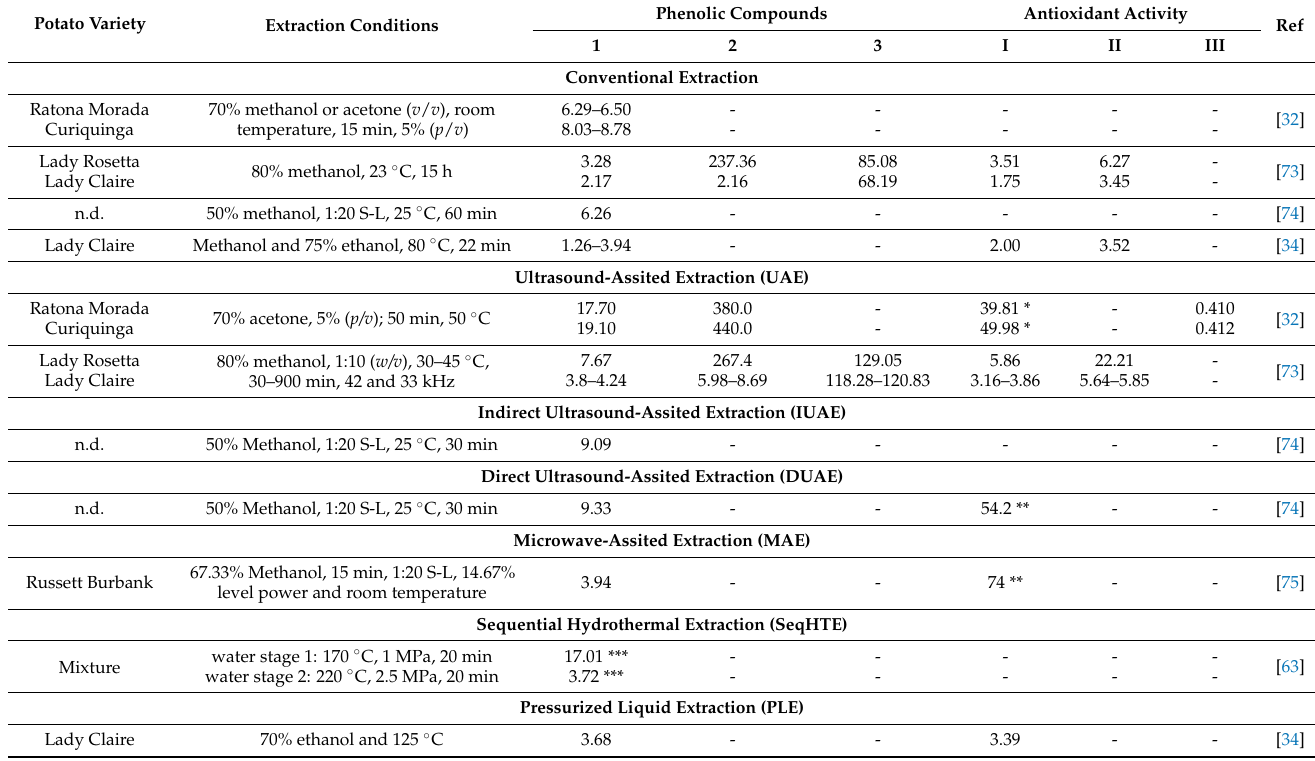
Table 3. Phenolic compounds and antioxidant activities obtained in different potato peel varieties with different types and conditions of